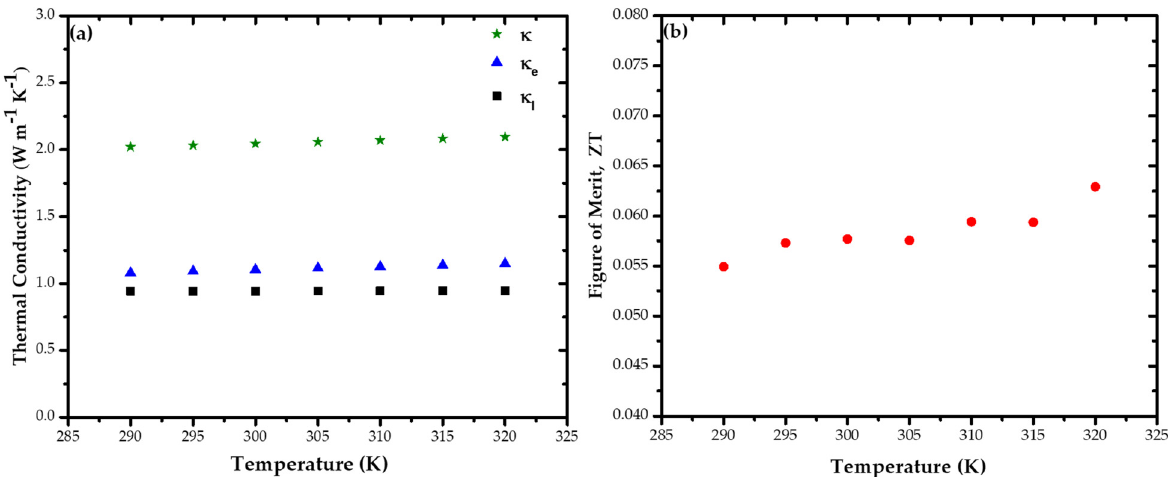
Figure 3. Temperature dependence regarding the ( a ) electrical resistance, ( b ) electrical conductivity, ( c ) TE power ( S ) and ( d ) power factor of the single-crystal Bi 2 S 3 NW.